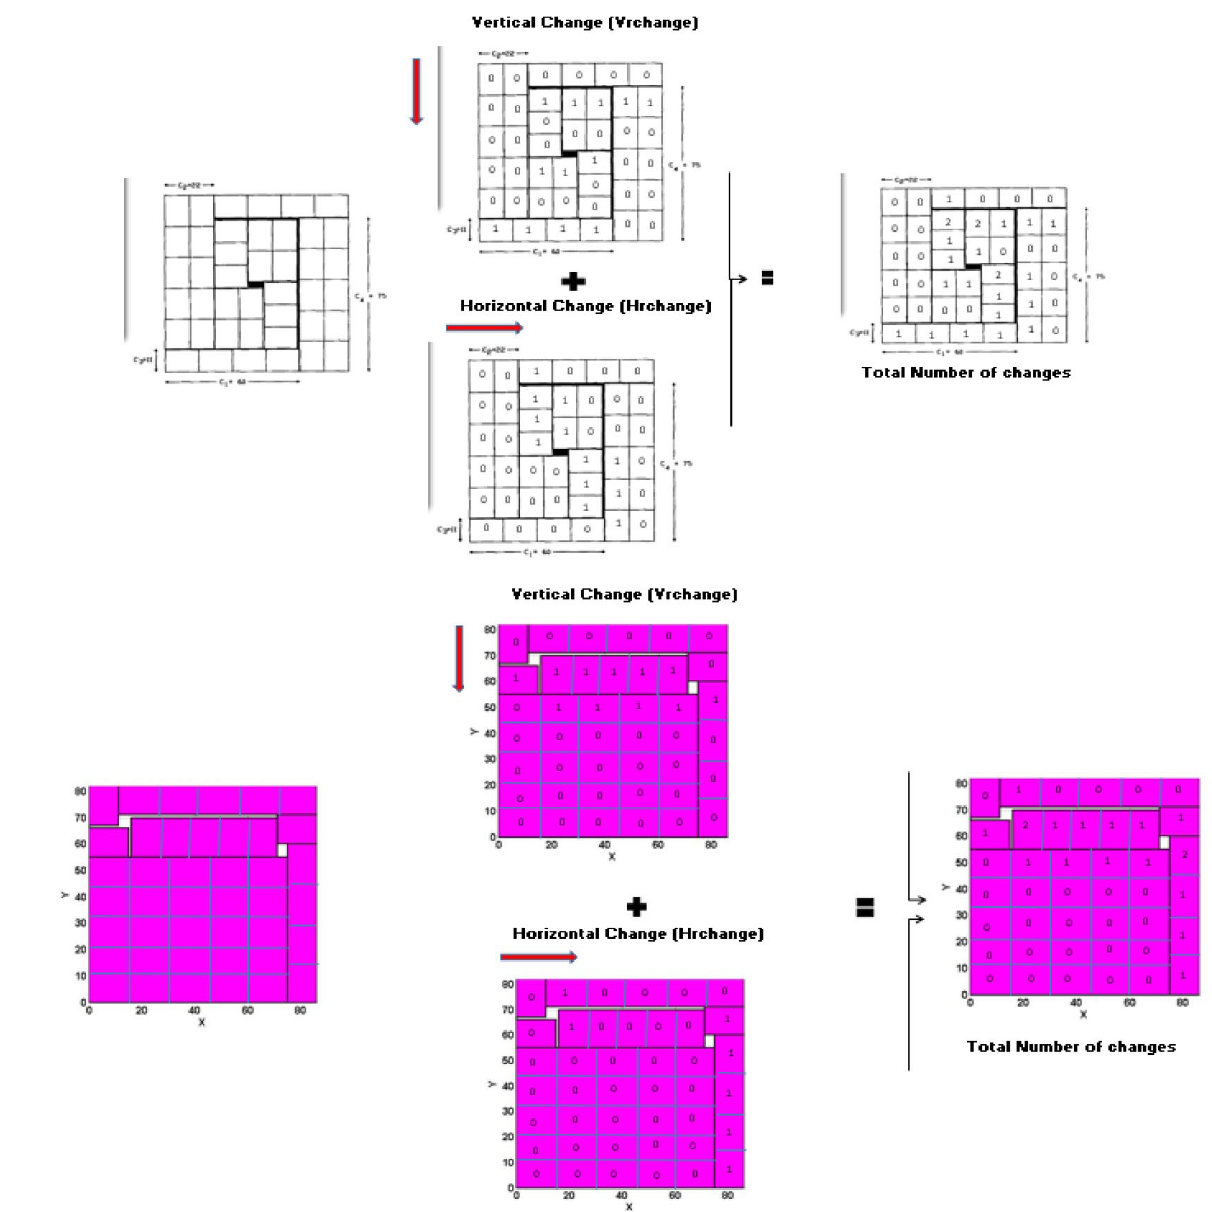
Figure 8. Complexity Index Calculation method for Instance